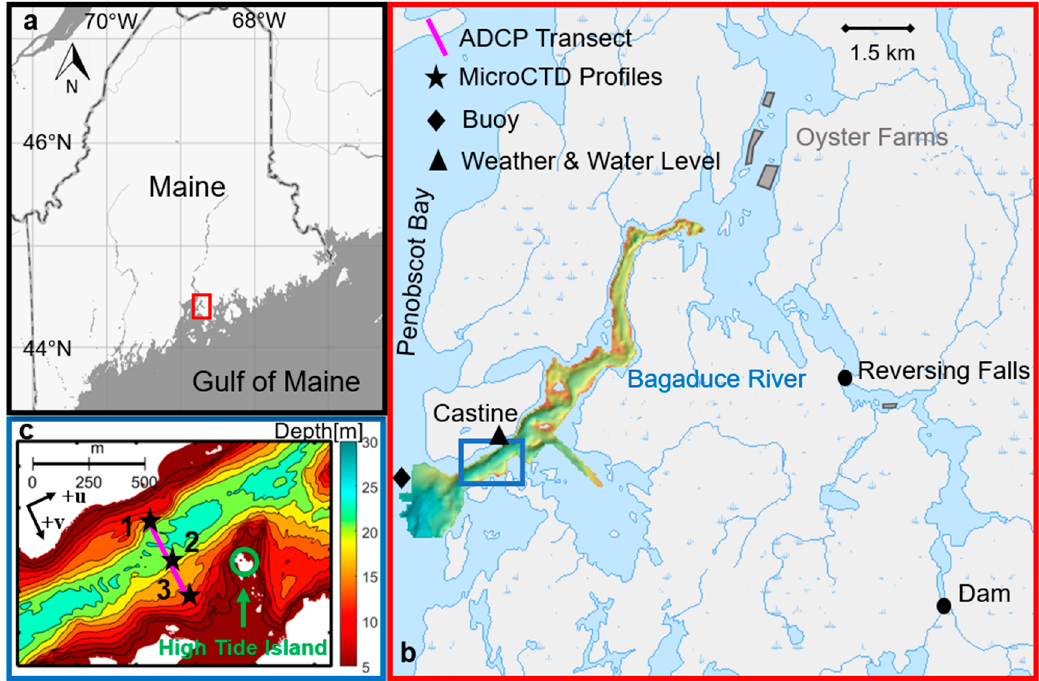
Figure 1. ( a ) The study area in relation to Maine, with the Bagaduce River located in the red box. ( b ) A zoom in on the Bagaduce River with depth indicated by contours. Weather station/water level (triangle) and buoy (diamond) locations are marked. Approximate locations of oyster farms are indicated by gray boxes. ( c ) A zoom in on the data collection transect location at the mouth of the estuary. An acoustic doppler current profiler (ADCP) sampled along the magenta line and MicroCTD profiles were taken at each station (stars).